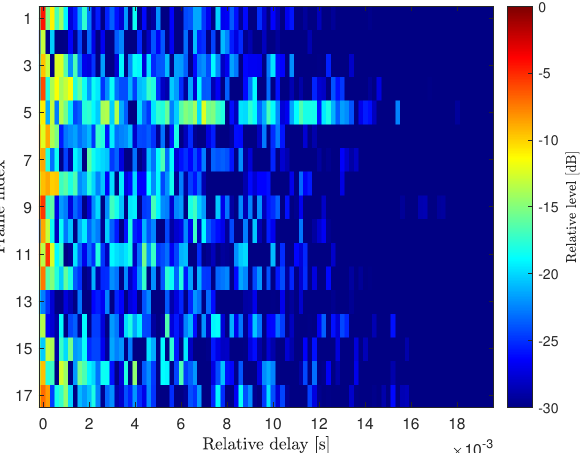
Figure 6. CIR estimate during the whole experimental period.